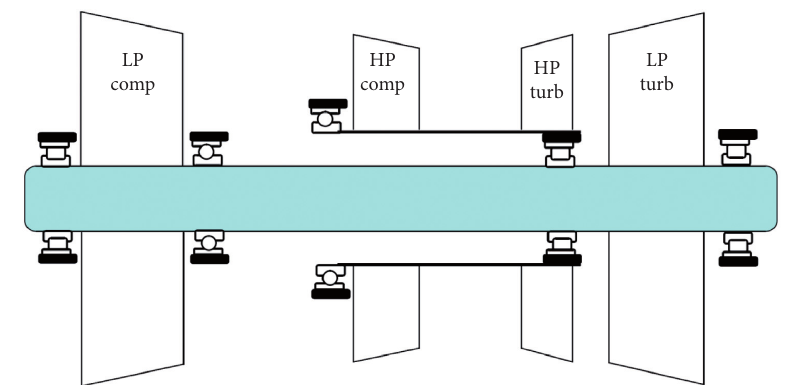
Figure 1: Structural diagram of a typical twin-spool jet engine [42].